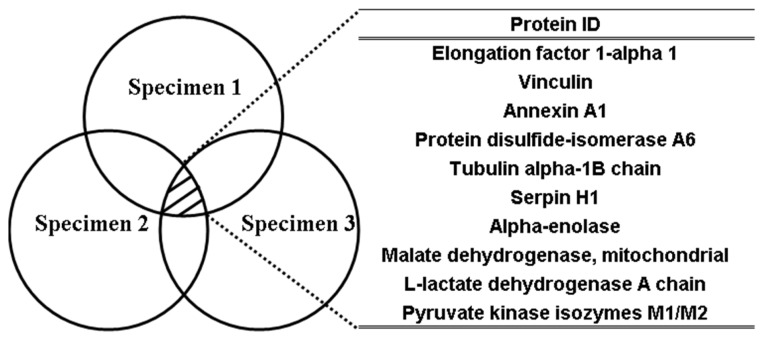
Triplicate experiments from chemical probes generated with NRK-52E lysates, intersection of triplicate experiments developed a protein list in which proteins score above 90, and at least the ratio (D/H) >3 of two experiments.